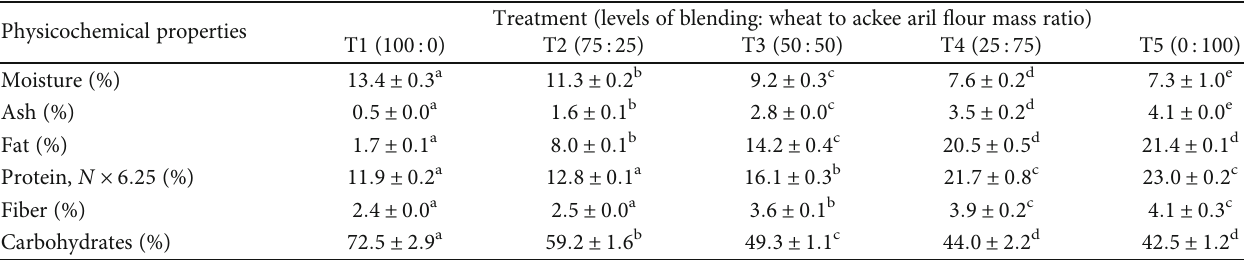
Valuesare presentedas mean ± standarddeviation ( n = 3 × 2 ). Di ff erentlowercaseletters withinthe same row represent statistically signi fi cant di ff erences at 5% signi fi